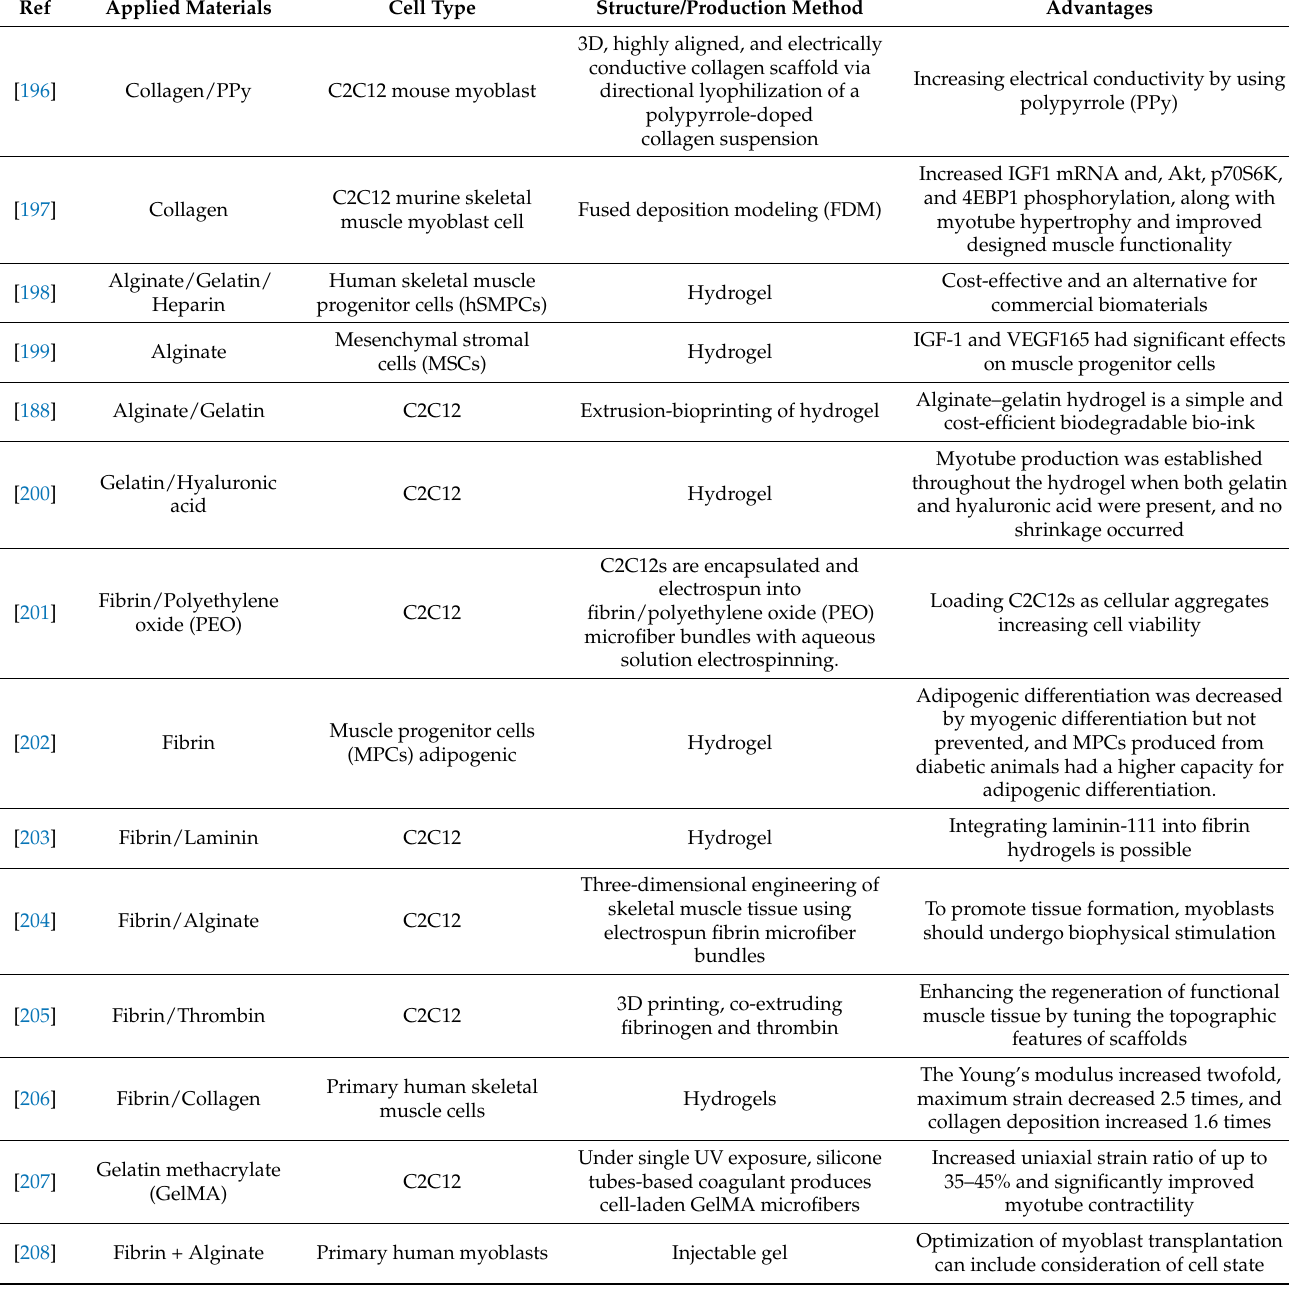
Table 3. Summary of recent studies using natural polymers in skeletal muscle tissue